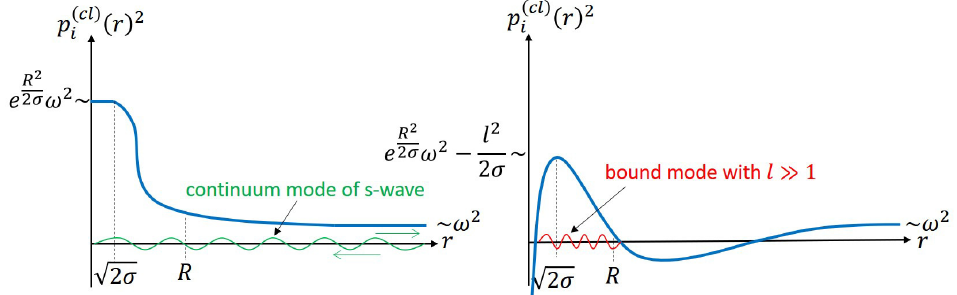
( cl ) ( r ) 2 for a given a . Left: l = 0, and Right: l (cid:29) 1. i